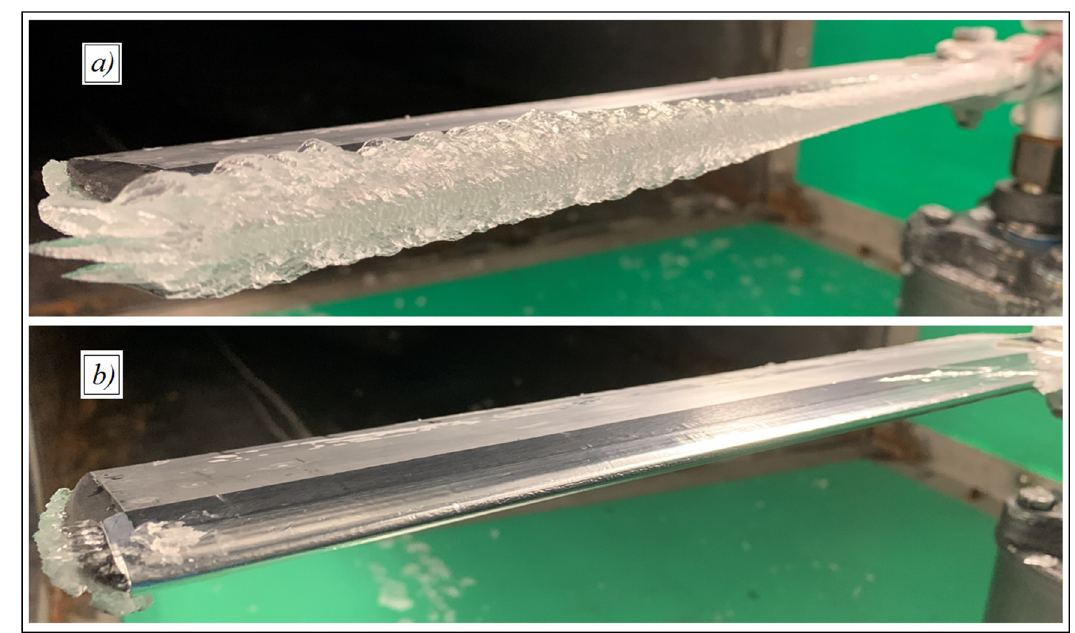
Figure 7. Photos of the De-Icing Test Process, ( a ) Ice Layer Accumulated across the Radius and on the Leading Edge of Blade ( Top ) and ( b ) Blade after Heating and Ice Totally Shed ( Bottom ).